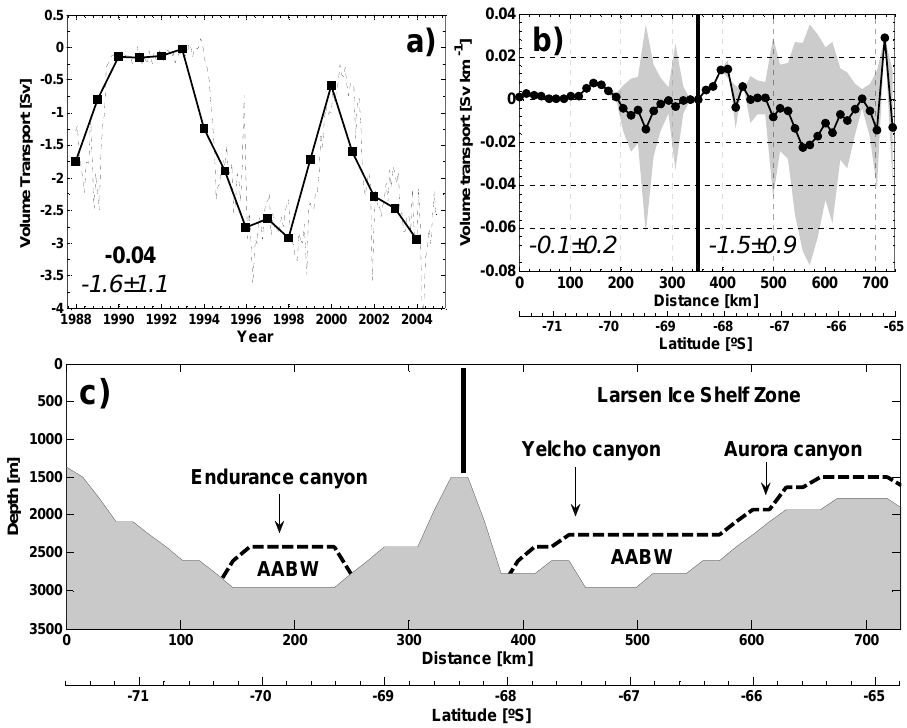
Fig. 14. (a) Monthly (dotted line) and annual (solid line) mean time series of AABW volume transport (in Sv) at northwestern Weddell Sea along-shelf-break section I (see Fig. 1b). The bold and italic annotations show respectively the decadal linear trend (Sv decade − 1 ) and the average and standard deviation for the entire period. (b) Same as described in (a) , but vertically integrated and divided by the distance between the model grid points (Svkm − 1 ) . The italic annotations show the average and standard deviation for the zone delimited by the black line. (c) Model bathymetry along the section I with the position of the main submarine canyons indicated. The mean AABW layer flowing into the Weddell Sea is indicated by the dashed